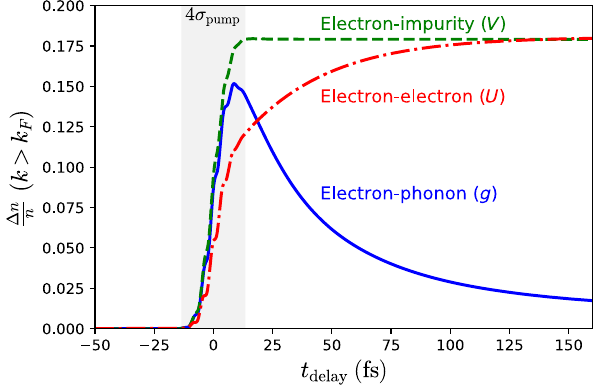
FIG. 4. Quasiparticle weight above the Fermi level for the individual electron-phonon, electron-impurity, and electron-electron interactions. The shaded region indicates (cid:3) 2 σ of the pump